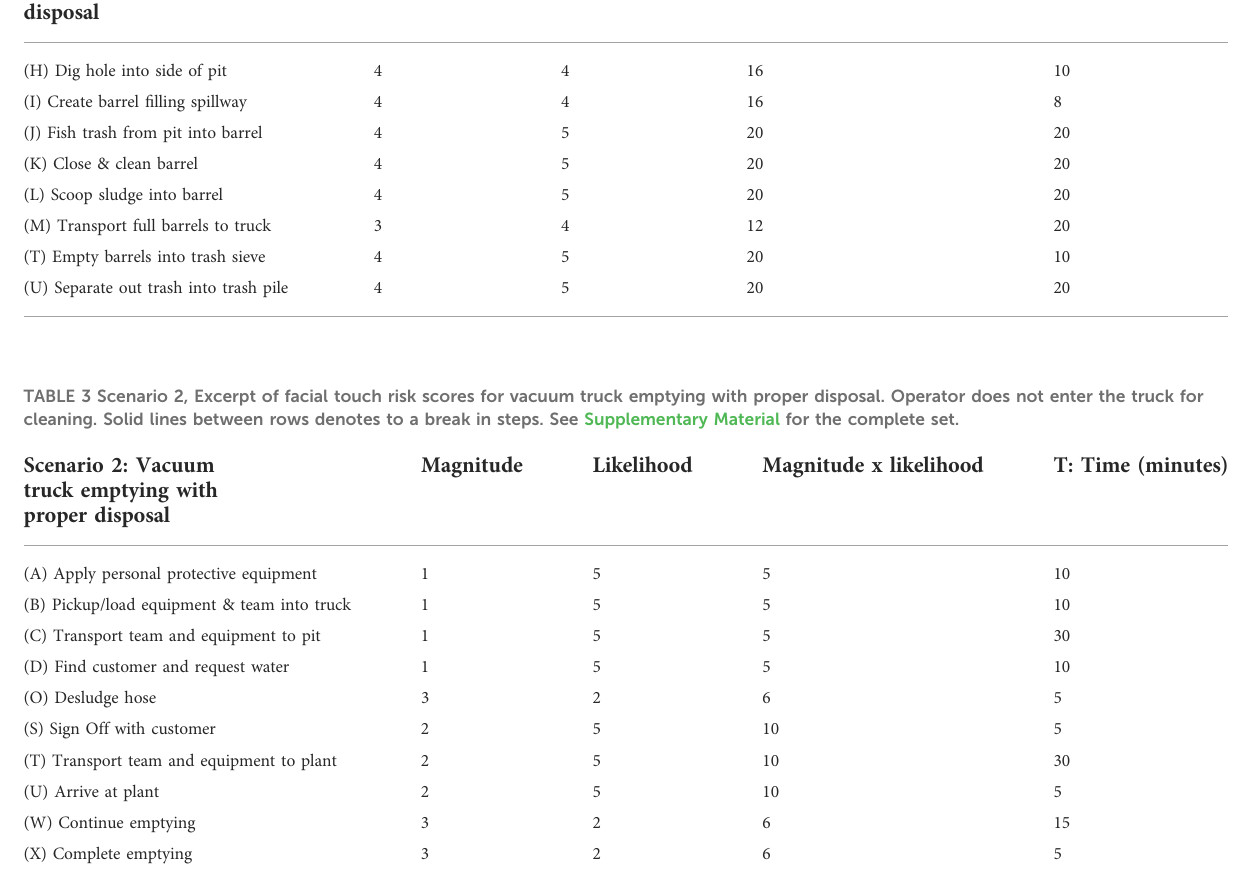
TABLE 2 Scenario 1, Excerpt of fecal aerosol inhalation risk scores for manual emptying with proper disposal. Solid lines between rows denotes to a break in steps. See Supplementary Material for the complete set. Scenario 1: Manual emptying with proper disposal